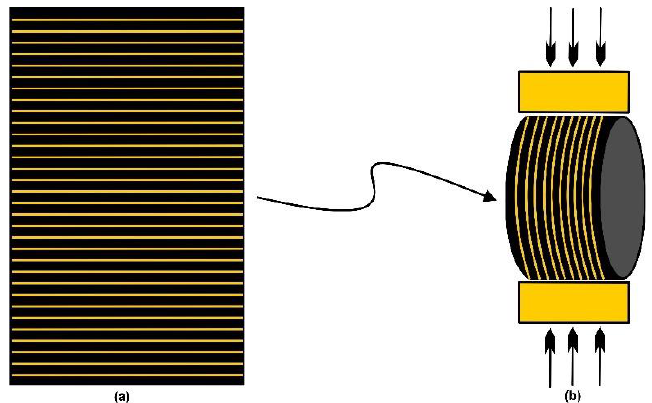
Figure 3. Schematic representations of ( a ) a vertical plug, and ( b ) a Brazilian disc-shaped sample.